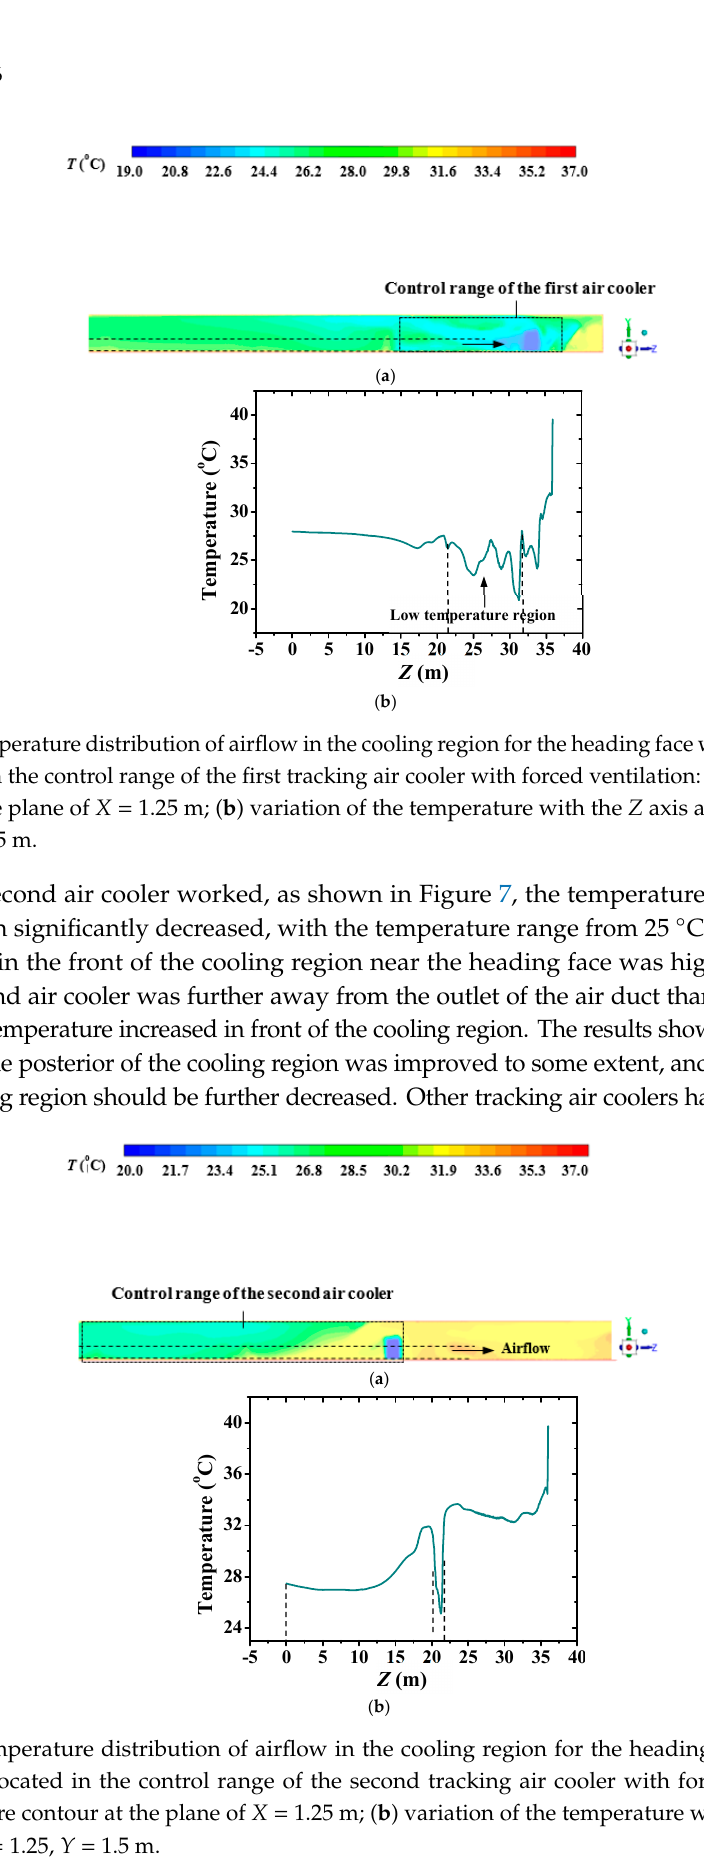
Figure 7. Temperature distribution of airflow in the cooling region for the heading face when the worker was located in the control range of the second tracking air cooler with forced ventilation: ( a ) temperature contour at the plane of X = 1.25 m; ( b ) variation of the temperature with the Z axis at the line of X = 1.25, Y = 1.5 m.